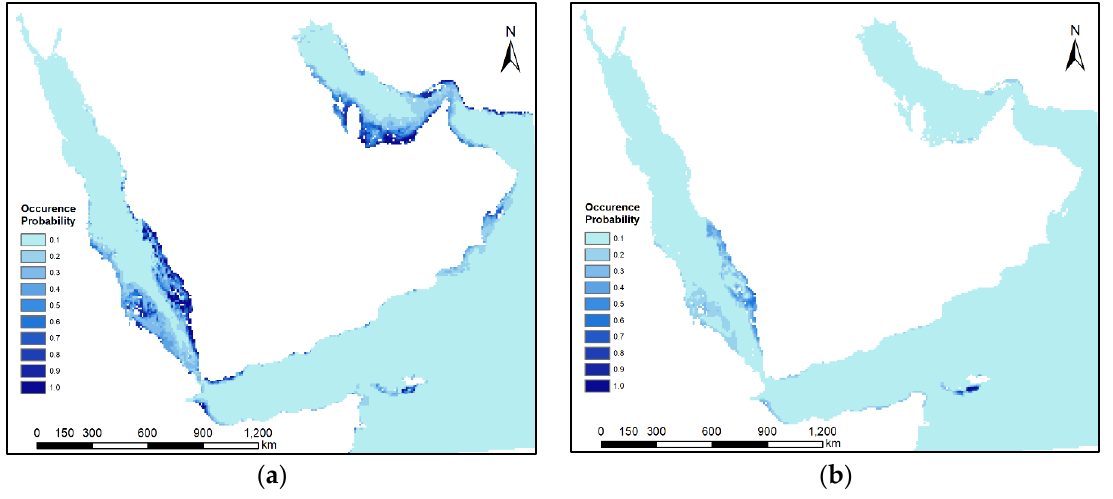
Figure 3. Potential current and future geographic distribution of Phalacrocorax nigrogularis : ( a ) predicted current distribution, ( b ) projected future distribution under SSP5-8.5 scenario in 2050. Table 2. Suitability area for Phalacrocorax nigrogularis in each region expressed in surface area.